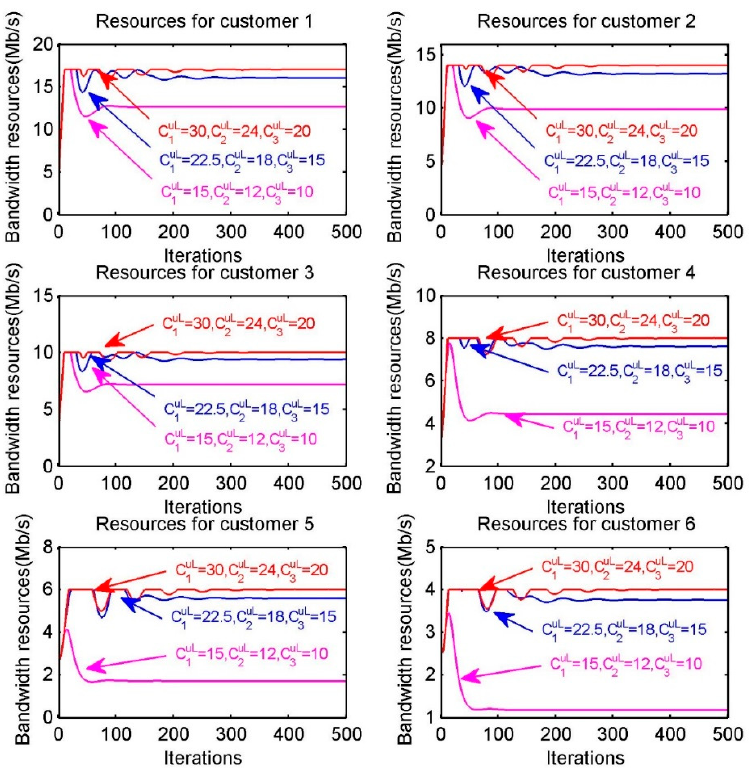
Figure 6. Optimal bandwidth resource allocation of each customer 𝑠 when increasing the upload capacity of providers.